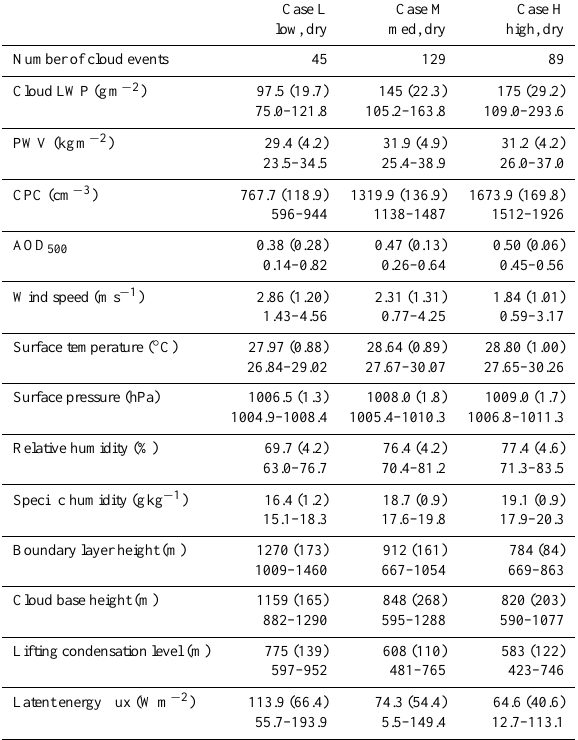
Table 4. Average surface values for low, medium, and high pol- lution for dry conditions (Cases L, M, and H, respectively). The numbers in parentheses indicate 1 standard deviation of the minute-averaged values for which PWV < 40kgm − 2 and CPC < 1000cm − 3 (low pollution), 1000 < CPC < 1500cm − 3 (medium pollution), or CPC > 1500cm − 3 (high pollution). Due to the non- normal distributions of many of these parameters, the 10th and 90th percentile ranges are additionally shown (second line). LWP and cloud base height are the averages over cloud events only, as is boundary layer height, to illustrate the position of cloud relative to the boundary layer. Lifting condensation level is calculated from the approximation given in Lawrence (2005). Eddy covariance cal- culations require a 30min averaging period; additionally, eddy co- variance fluxes were unresolvable during nighttime due to the low wind speeds. Thus, the values of LEF below are for 30min aver- aged daytime fluxes (06:00–18:00MVT) only. The corresponding 24h values are 98 . 5 ± 63 . 4 (37.4–169.3), 70 . 4 ± 51 . 5 (5.2–127.8),